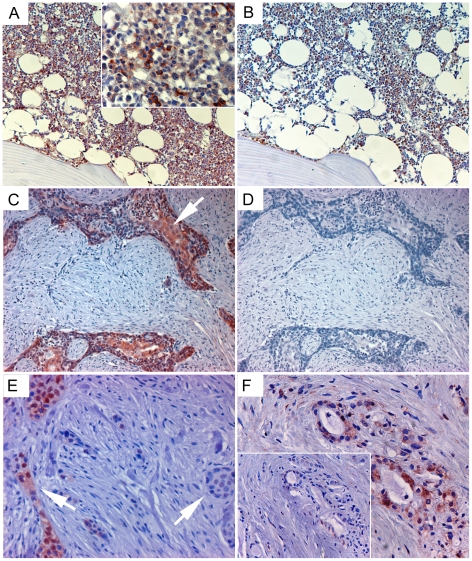
Detection of EpoR-positive tumor cells in PDAC pancreata.(A) Staining of erythroid precursor cells in human bone marrow with anti-EpoR 3D10 antibody (inset, ×400) and (B) loss of staining if the anti-EpoR antibody has been pre-incubated with soluble EpoR (sol-EpoR). (C, E) Varying intensity and focal character of EpoR-immunopositivity of tumor cells in PDAC tissues (arrows) and (D) blocking of EpoR signal with sol-EpoR. (F) Sporadic EpoR-immunopositivity of non-malignant structures within a PDAC sample and blocking of EpoR signal with sol-EpoR (inset).